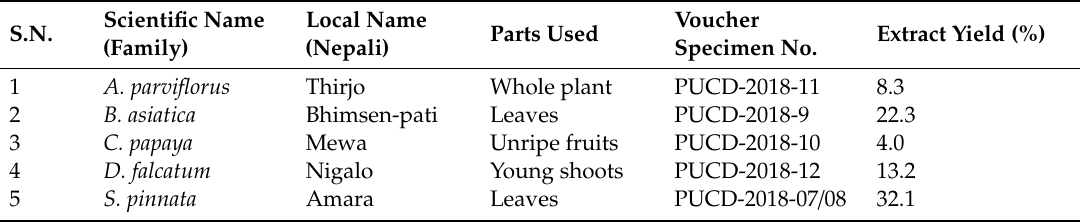
Table 1. List of plants selected for the study, parts used, voucher specimen numbers and extract yield